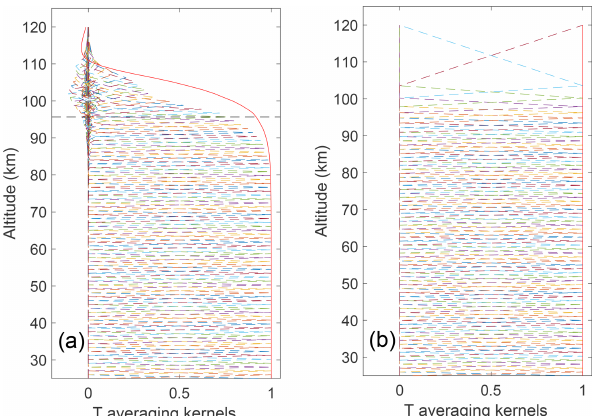
Figure 15. The PCL averaging kernels for the temperature retrieval on 12 May 2012 on the fine grid (a) and on the coarse grid (b) . The A u = 0 . 9 cutoff height on the fine grid is shown by the black horizontal dashed line at 97km. The red lines on the edges of the averaging kernels are the measurement response. The coarse grid extends the temperature upwards by